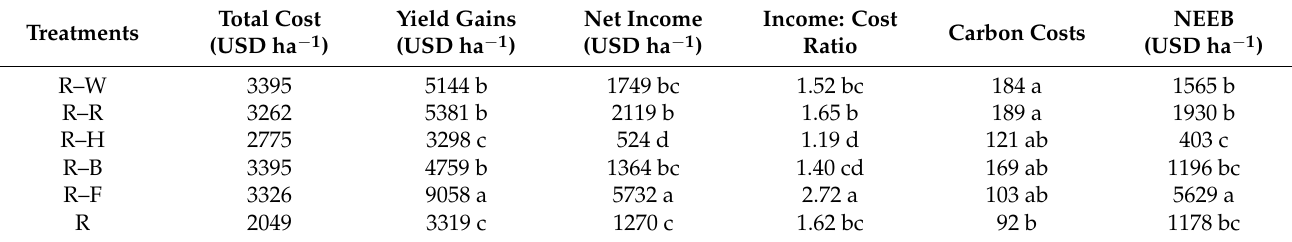
Table 5. Effects of different cropping systems on the economic benefit and